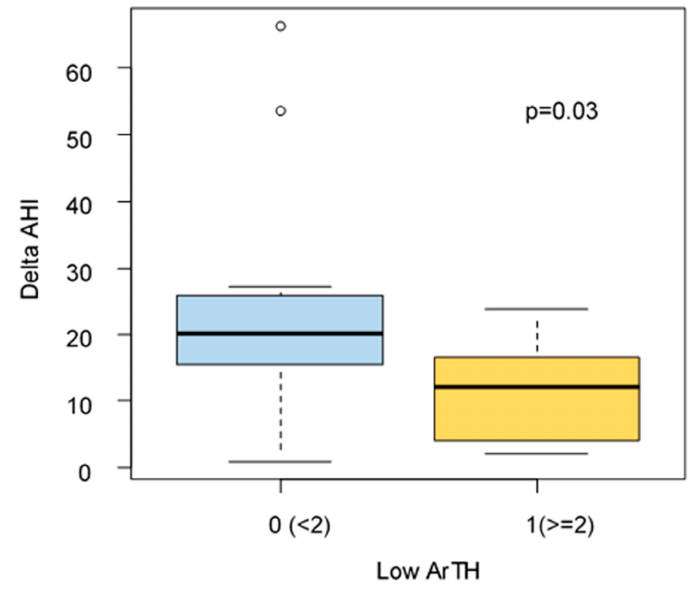
Figure 2. AHI variation related to low ArTH ( p -value = 0.03).